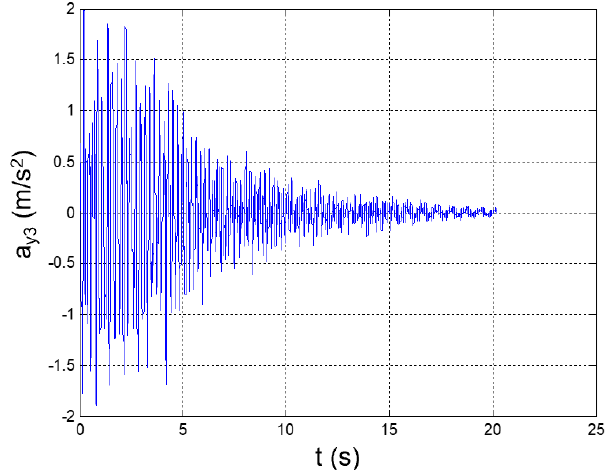
Figure 6. Seismic response, 2nd-floor acceleration (Node 46) with respect to the ground.